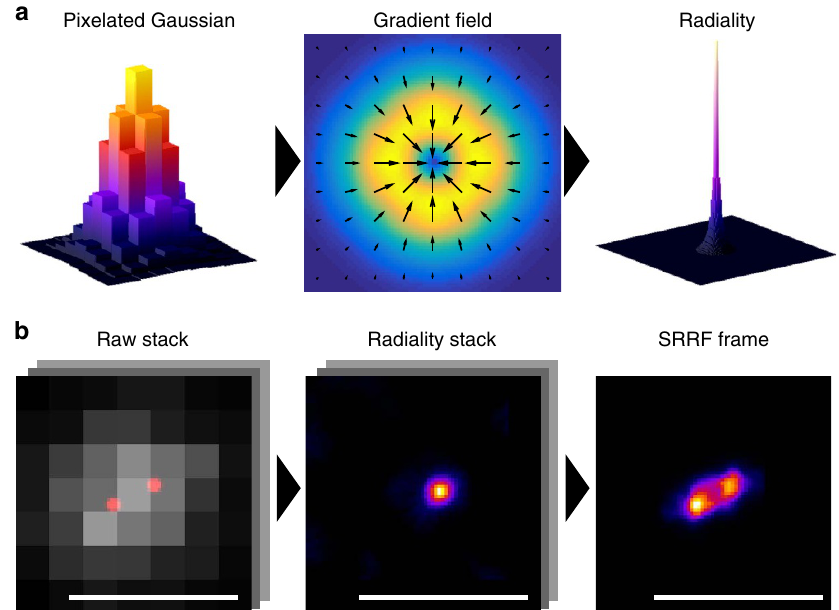
Figure 1 | The SRRF algorithm. ( a ) Spatial analysis. Left: 3D surface plot of a pixelated simulated widefield PSF. Middle: surface plot of the gradient magnitude (arrows indicate direction). Right: 3D surface plot of the measured radiality PSF. ( b ) Temporal analysis. Left: a 100 frame simulation of a pair of fluctuating fluorophores separated by the sigma ( s ) of the widefield PSF (135nm). The true fluorophore positions are indicated in red and the pixelated simulated noisy intensity distribution is shown in grey. Middle: stack of radiality maps obtained by applying radiality to each image in the simulated image sequence. Right: SRRF image acquired by higher-order temporal analysis of the stack of radiality maps. Scale bar,